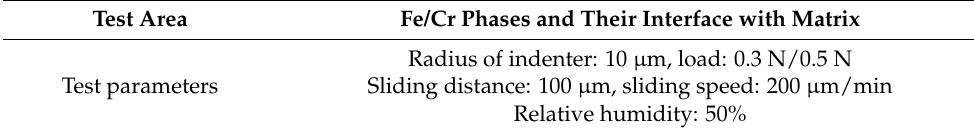
Table 4. Microfriction test parameters for different areas.